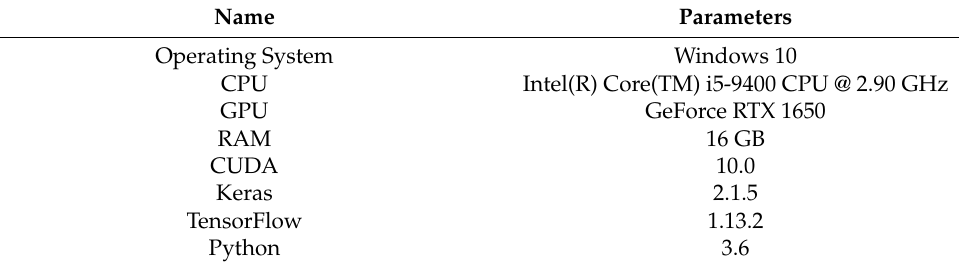
Table 1. Experimental